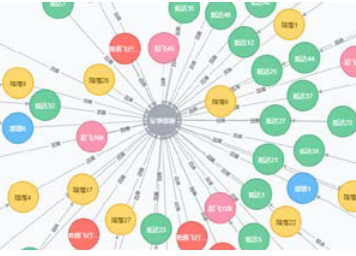
Fig. 5. A part of air target combat intention